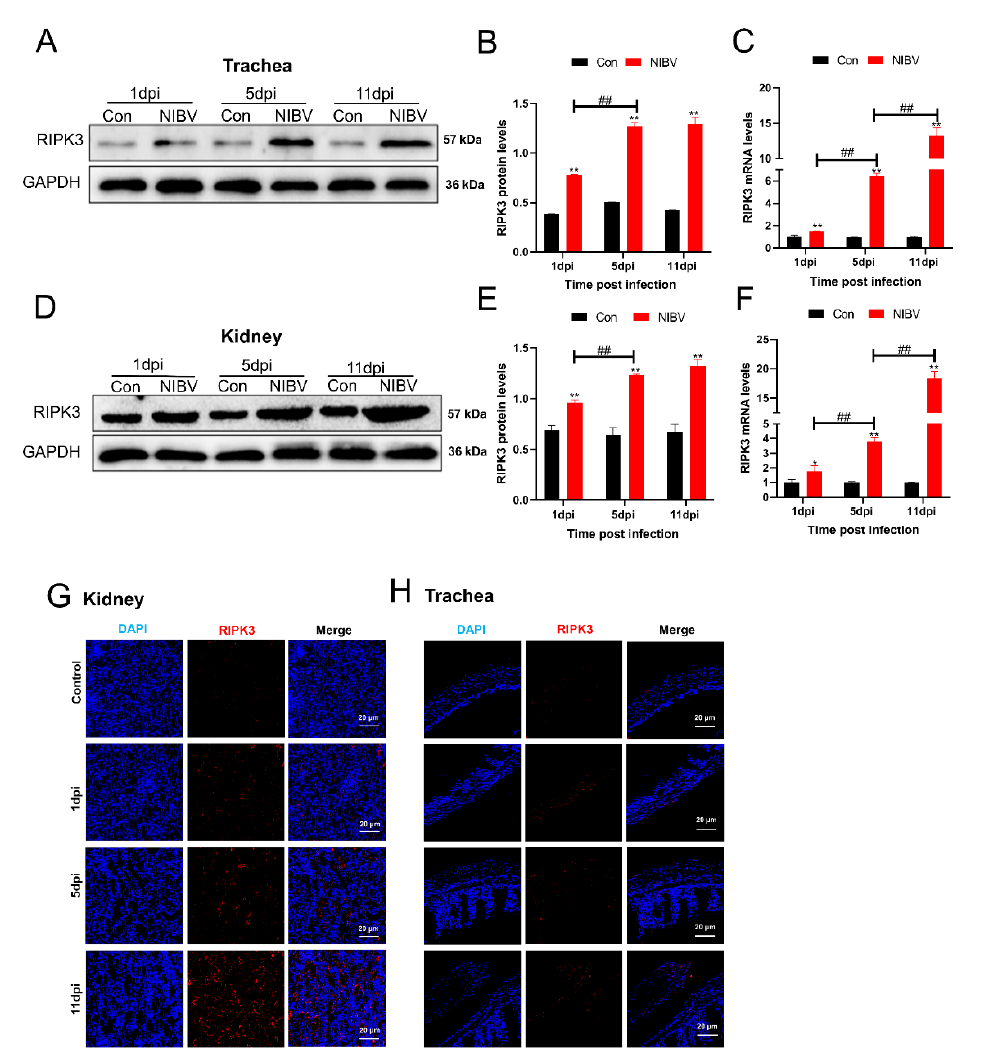
Figure 6. NIBV infection upregulates the protein expression levels of RIPK3 in the trachea and kidney. ( A ) The total protein extracted from tracheal tissues collected at 1-, 5-, and 11-days post infection was subjected to Western blot analyses. ( B ) Quantification of RIPK3 expression relative to gapdh. ( C ) RIPK3 mRNA levels of tracheal tissues were examined by real-time PCR. ( D ) After NIBV inoculation for 1 d, 5 d, and 11 d, the expression levels of RIPK3 in kidney tissues were detected by Western blot. ( E ) Quantification of RIPK3 expression in the kidney relative to gapdh. ( F ) The changes in RIPK3 mRNA levels in response to NIBV infection. ( G , H ) Fluorescence microscopy analyzed the fluorescence intensity of endogenous RIPK3 (red) in renal tissues ( G ) and tracheal tissues ( H ) after NIBV infection for 1 d, 5 d, and 11 d. Scale bar: 20 µ m. The data in the results are expressed in the form of mean ± SD ( n = 3). The data are expressed as mean ± SD. A difference was considered significant if p < 0.05. Statistical extreme significance was defined as p < 0.05 (*, #), p < 0.01(**,